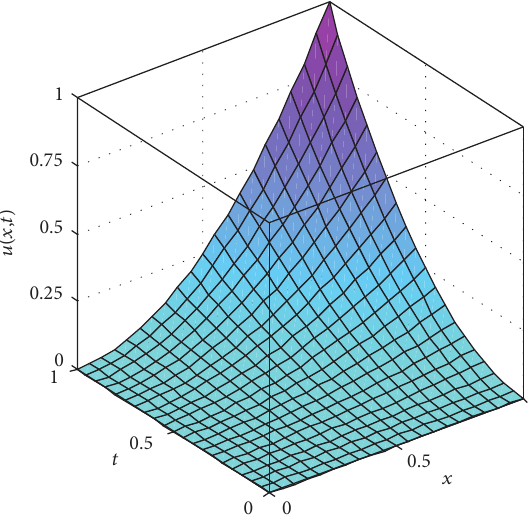
Figure 2: Numerical solution with 𝑚 = 8 for Example 1.